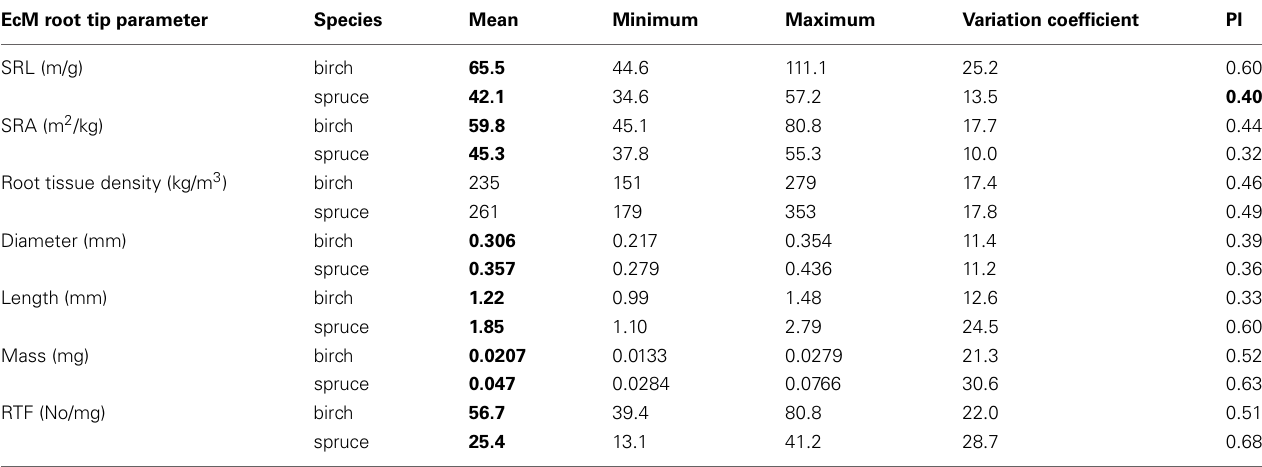
Table 4 | The means and variation between stand means of morphological characteristics of EcM root tips and their PI values in silver birch and Norway spruce